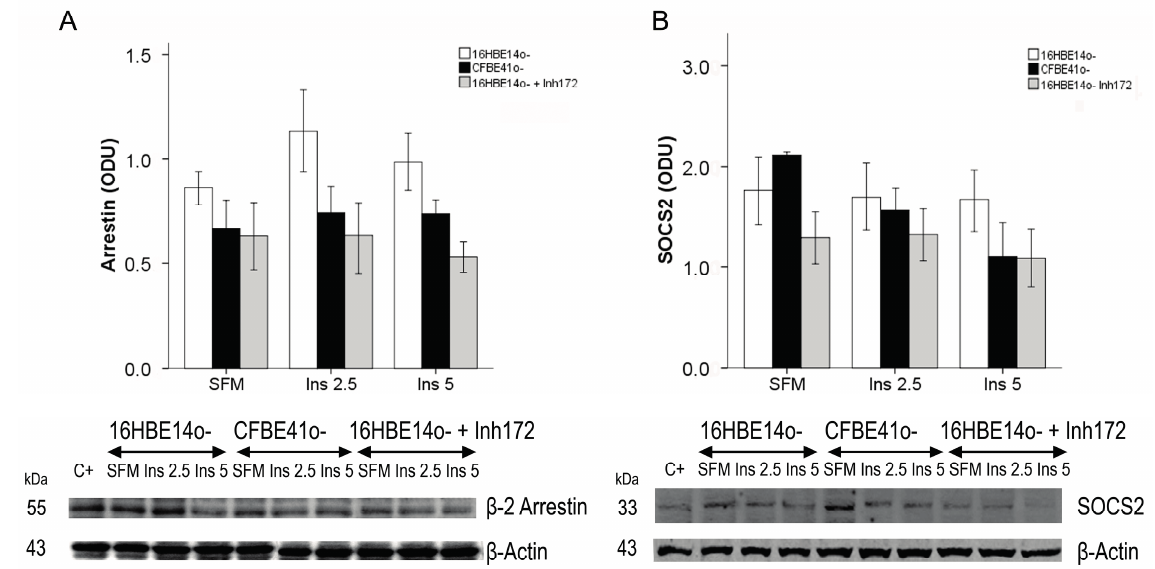
Figure 4. β 2 arrestin ( A ), and suppressor of cytokine signaling (SOCS) 2 ( B ) in CF-affected and normal cells. ( A ) β 2 arrestin, expressed in ODU, was lower, albeit not significantly, in CFBE41o- cells. Treatment of 16HBE14o- cells with a CFTR inhibitor (Inh172) did not determine any change in baseline conditions (serum-free medium—SFM), whereas in the presence of insulin, β 2 arrestin content decreased noticeably; ( B ) Suppressor of cytokine signaling (SOCS) 2 was similar in both cell lines and did not change with insulin treatment. Treatment of 16HBE14o- cells with Inh172 lowered SOCS2 content to concentrations similar to those observed in CFBE41o- cells in the presence of insulin, although statistical significance was not attained. Bars represent the mean ± SEM of all experiments in both groups ( n = 4). Beneath are representative Western immunoblots of samples from 16HBE14o-, CFBE41o- and 16HBE14o- treated with Inh172 as specified